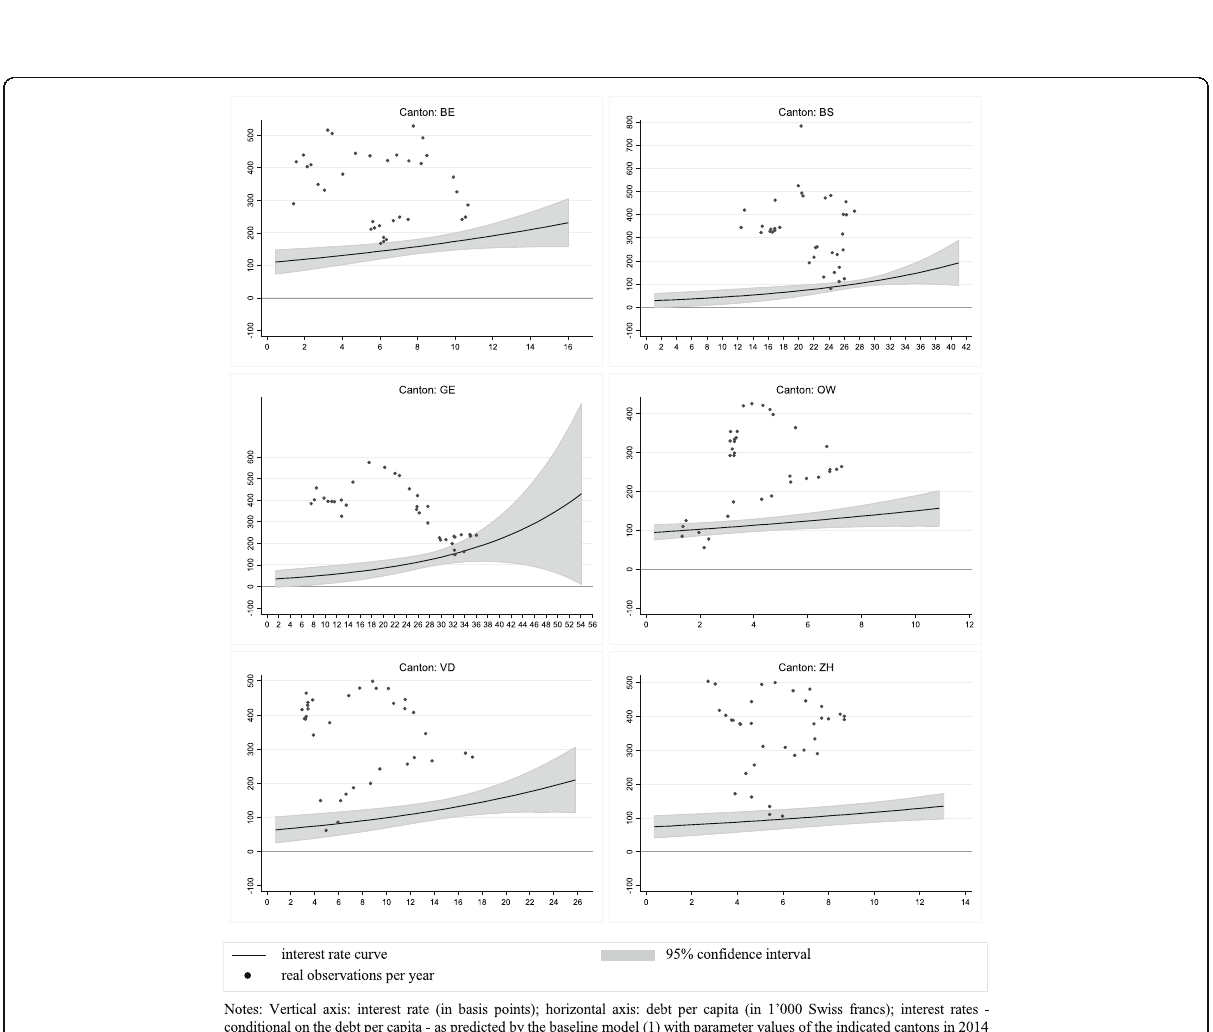
Fig. 4 Predicted interest rate curve for the year 2014